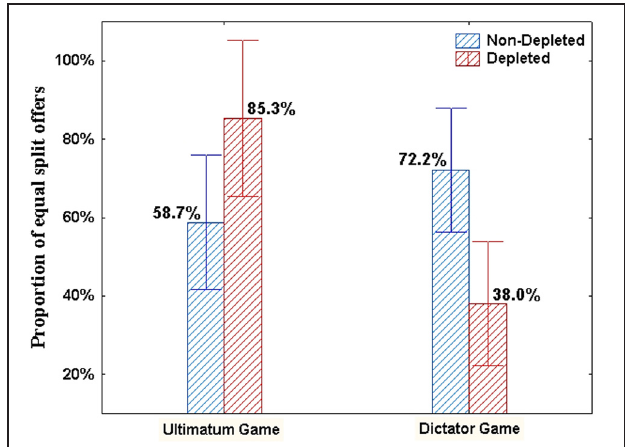
FIGURE 2 | Means and standard errors of the proportionof equal split offers in Experiment 2 as a function of Game and Condition.